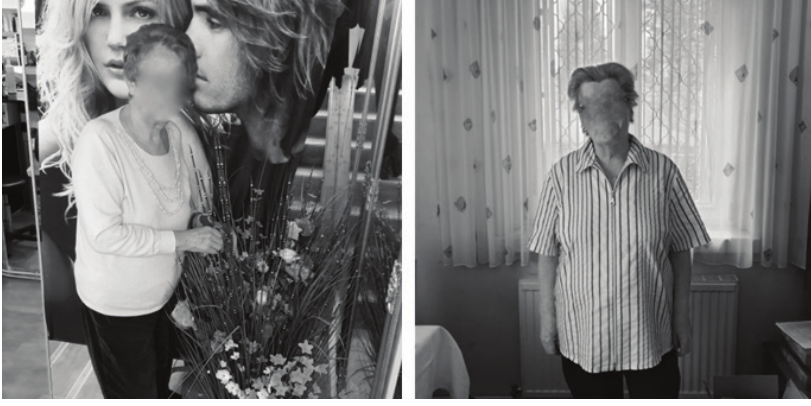
Figure 2. Examples of body work in the visual diaries of